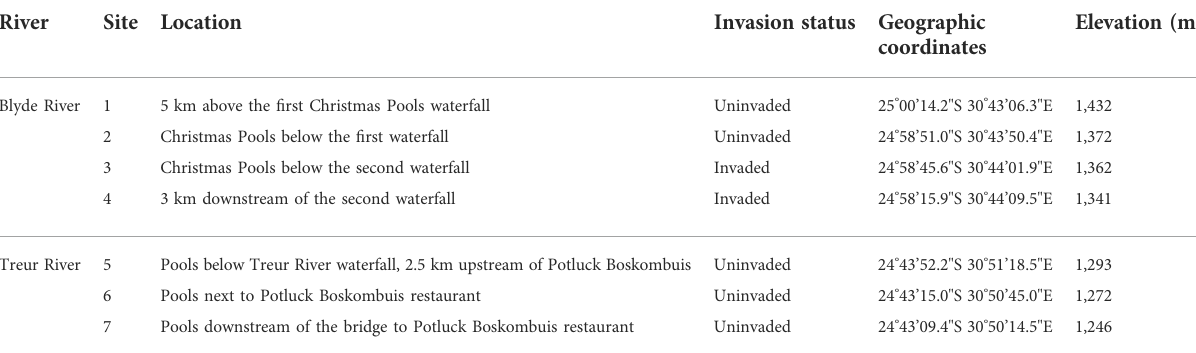
TABLE 1 Sampling sites on the Blyde and Treur rivers in Mpumalanga Province, South Africa and their associated rainbow trout ( Oncorhynchus mykiss ) invasion status, geographic coordinates, and elevation.